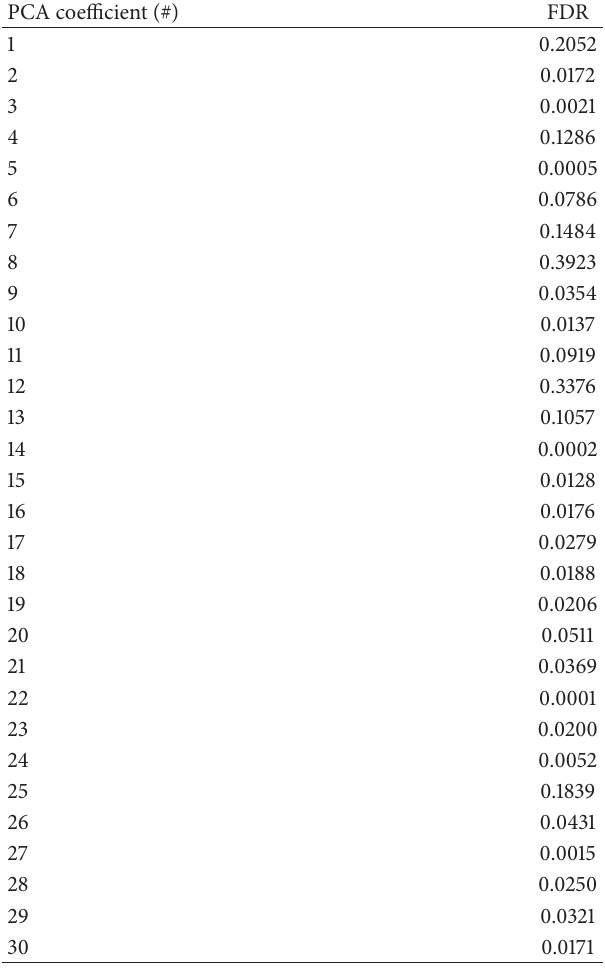
Table 2: FDR values of the 30 features (PCA coefficients) used for the ED versus HC